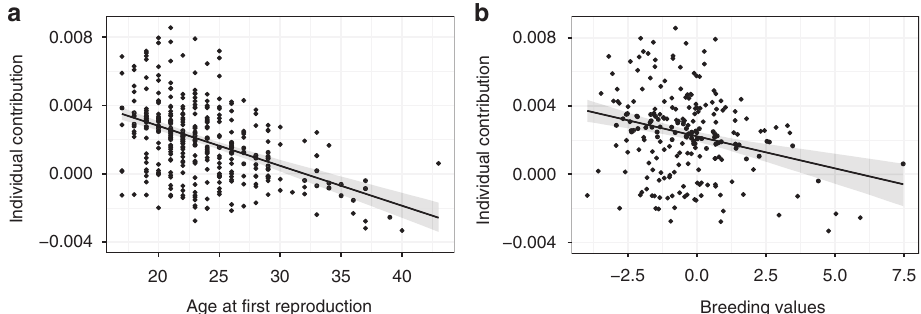
Figure 1 | Links between age at first reproduction and lifetime individual contributions. Effect of ( a ) individual age at first reproduction and ( b ) breeding values for age at first reproduction on lifetime individual contributions to population growth (calculated as the sum of yearly individual contributions during a woman’s lifetime, N ¼ 220), at ıˆle aux Coudres for women born from 1772 to 1880. The predictions lines with 95% confidence intervals (generated from a parametric bootstrap) are from linear mixed models presented in Table